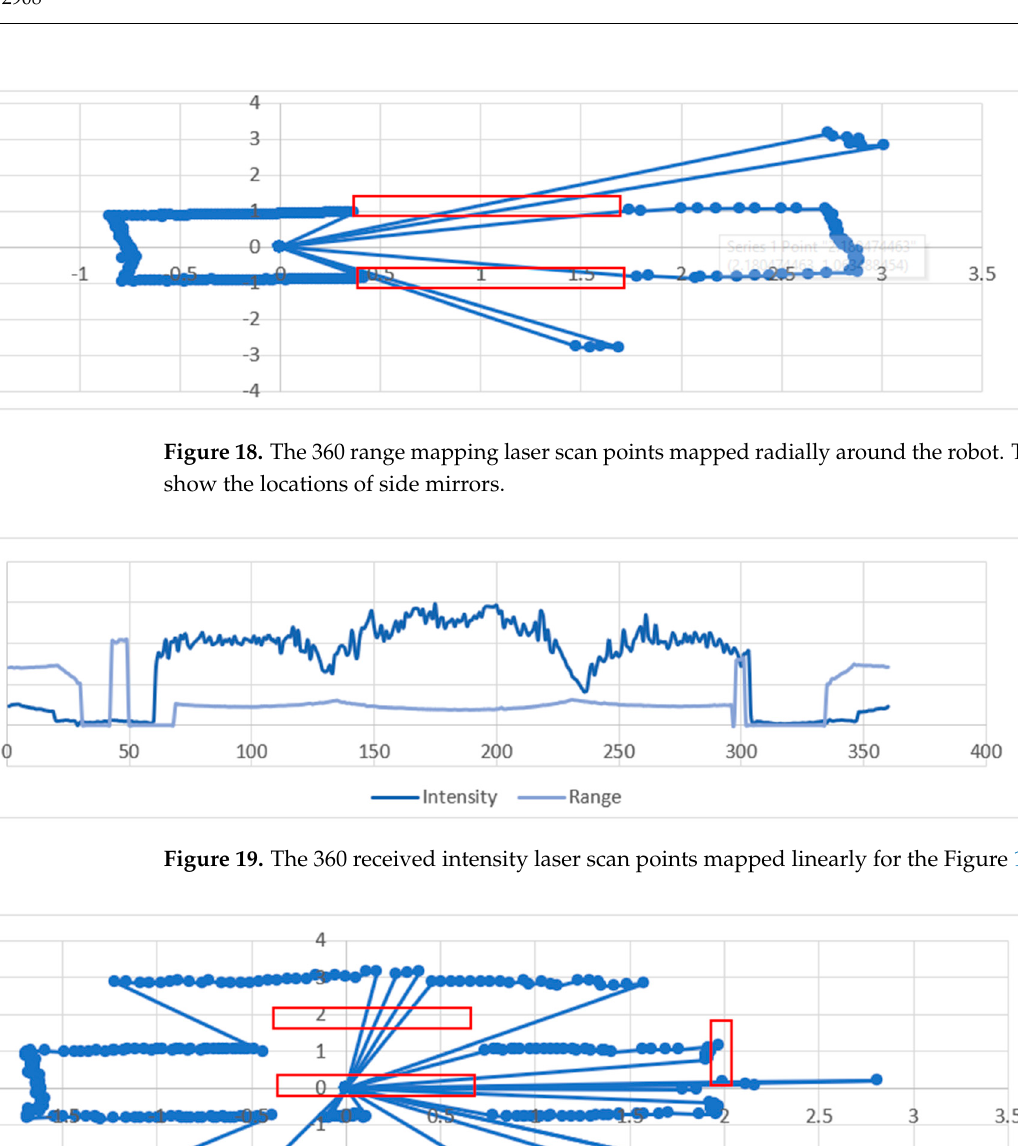
15 of 20 Figure 16. 360 laser scan points for range mapping radially around the robot. The red box shows the side mirror location.